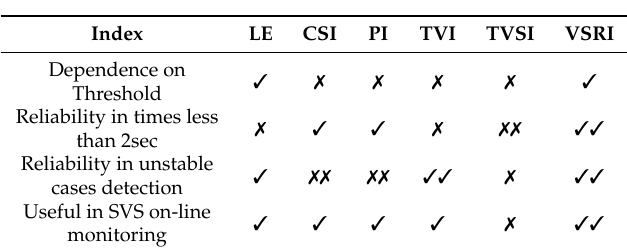
Table 3. Summary of index performance in SVS